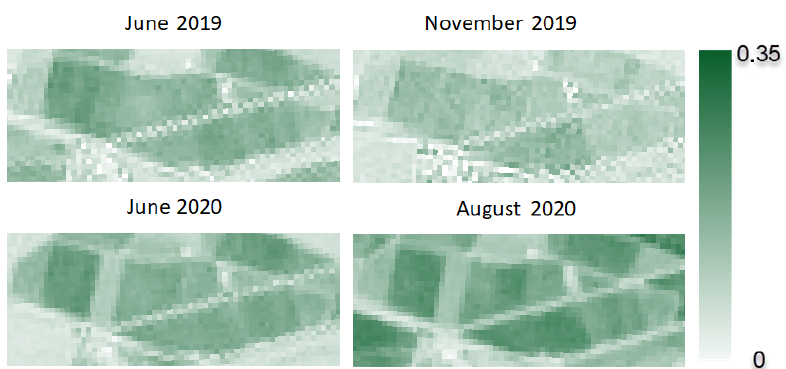
Figure 14. VOG index evolution in stone fruit tree exploitation.